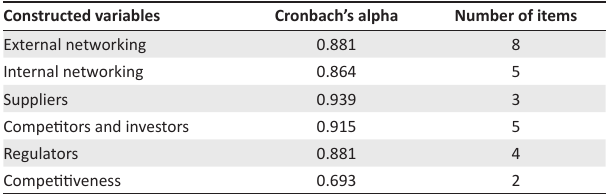
TABLE 1: Cronbach’s alpha’s reliability